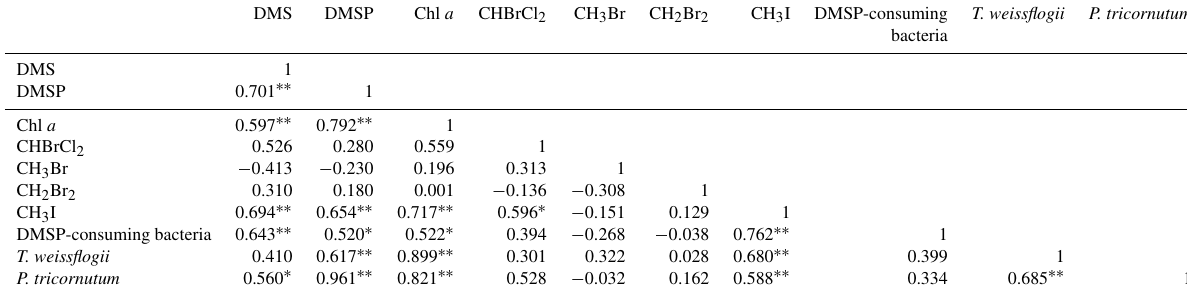
Table 2. Correlation between dimethylsulfide (DMS), dimethylsulfoniopropionate (DMSP), chlorophyll a (Chl a ), bromodichloromethane (CHBrCl 2 ), methyl bromide (CH 3 Br), dibromomethane (CH 2 Br 2 ), iodomethane (CH 3 I), DMSP-consuming bacteria, Thalassiosira weiss- flogii ( T. weissflogii ) and Phaeodactylum tricornutum ( P. tricornutum ) concentrations in the low p CO 2 treatments.